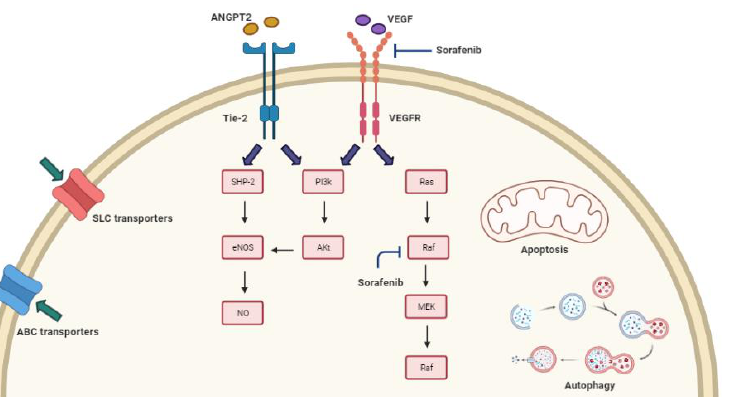
Figure 1. Resistance mechanisms to sorafenib in HCC patients; sorafenib resistance developing in HCC patients can be attributed to a complex of mechanisms, including Transport of the drug across the cell membrane, deregulated cell death mechanisms, the genetic variability of molecular targets and pathways as well as miscellaneous mutations including ANGPT-2 and NOS-3 genes. ABC: ATP-binding cassette; SLC: solute carrier; ANGPT-2: angiopoietin-2; Tie-2: type-I tyrosine kinase receptors; VEGF: vascular endothelial growth factor; VEGFR: vascular endothelial growth factor receptor; eNOS: endothelial nitric oxide synthase; NO: nitric